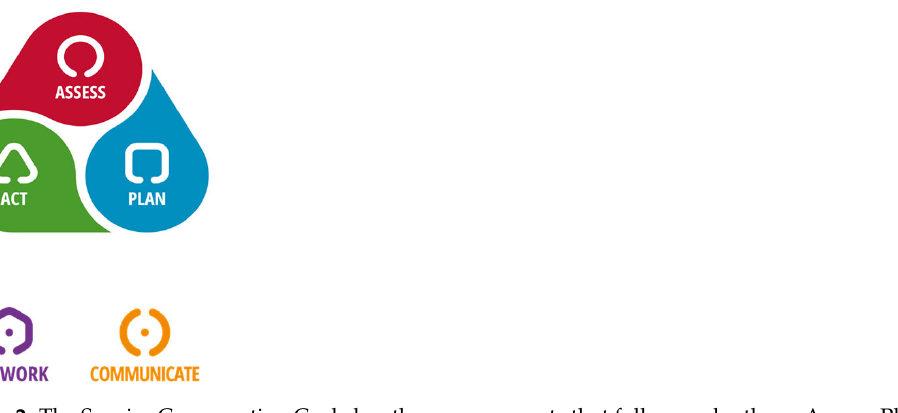
Figure 2. The Species Conservation Cycle has three components that follow each other—Assess, Plan, and Act—and two components that span across the others—Network and Communicate [8]. The first three components flow sequentially, while the other two are transverse